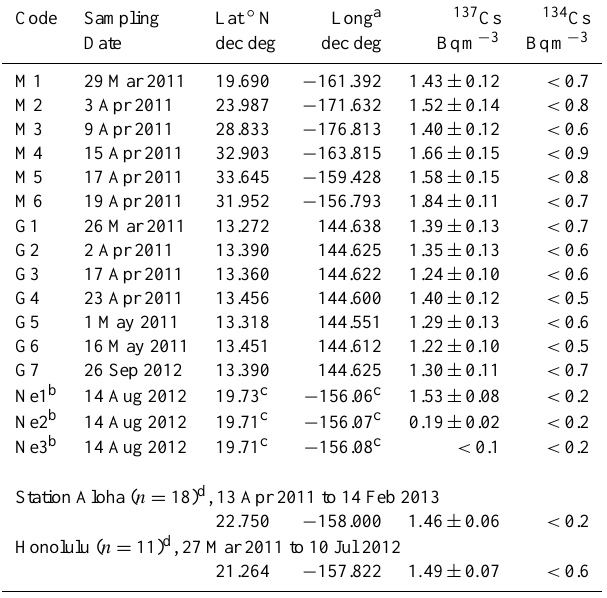
Table 1. Activities of 134 Cs and 137 Cs in seawater around Hawaiian Islands (M1–M6, Ne1–Ne3, Station Aloha, Honolulu) and Guam (G1–G7) after the Fukushima Dai-ichi Nuclear Power Plant acci- dent. Average and standard deviation is presented for samples from Station Aloha and Honolulu. All samples were collected from the surface except Ne1, Ne2, and Ne3. Activities are decay-corrected to